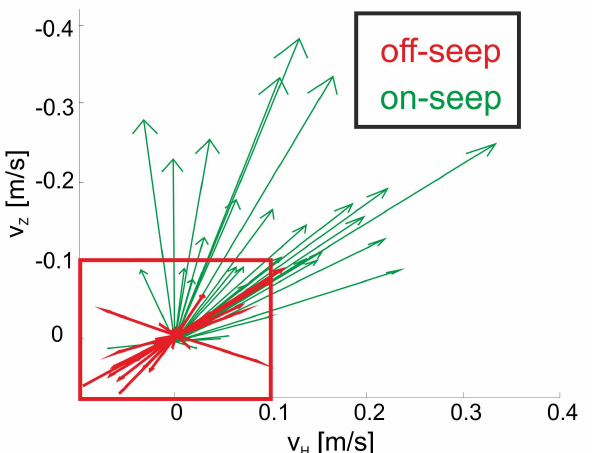
Fig. 5. Velocity vector components v z and v h calculated for the “on-seep” interrogation window (5, 4) and “off-seep” interrogation window (6, 3) in green and red, respectively. For the location of the interrogation window, see Fig.